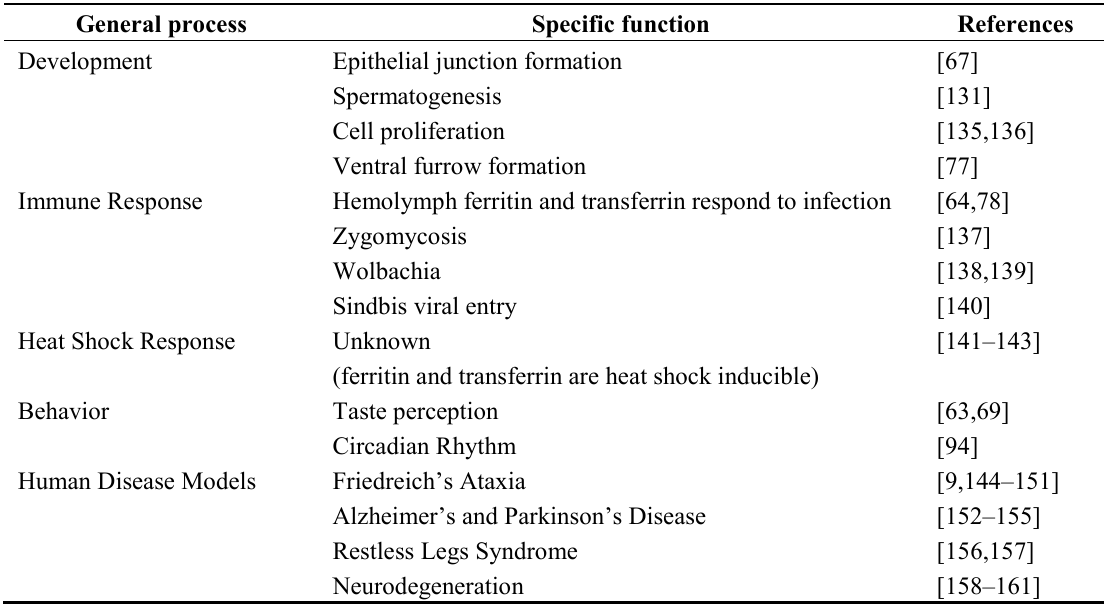
Table 4. Higher biological processes influenced by iron